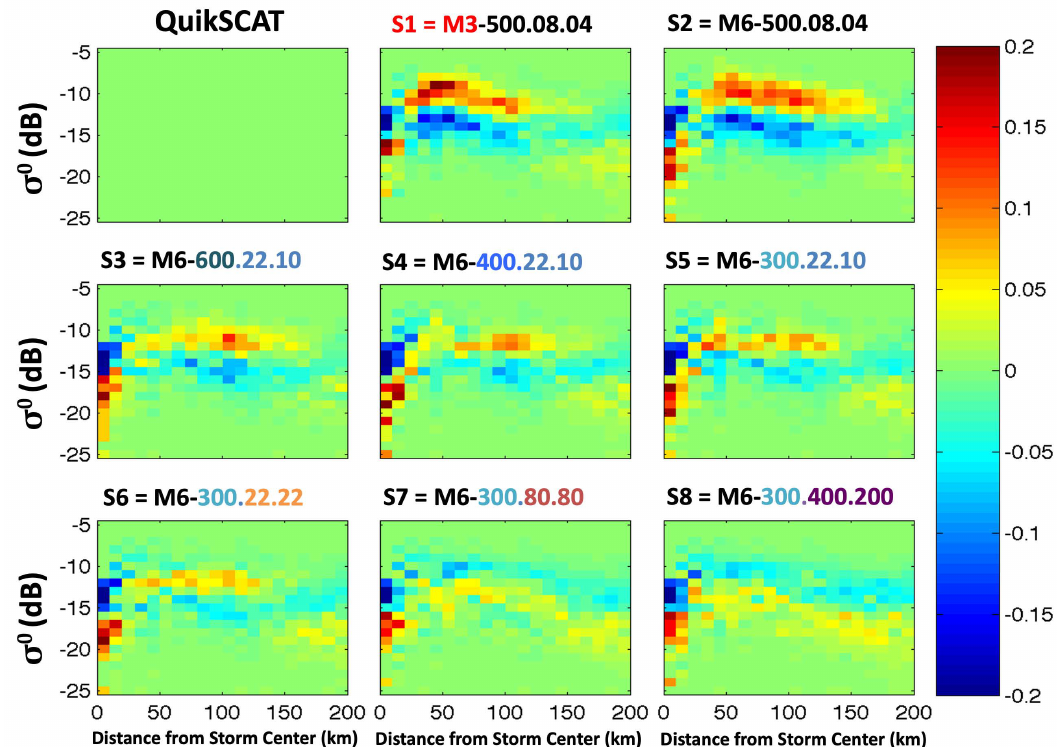
Figure 14. Same as in Figure 13, except for differences from the satellite observations made by QuikSCAT. The observations, and the eight different experiments, are arranged in the same order as in Figure 7.